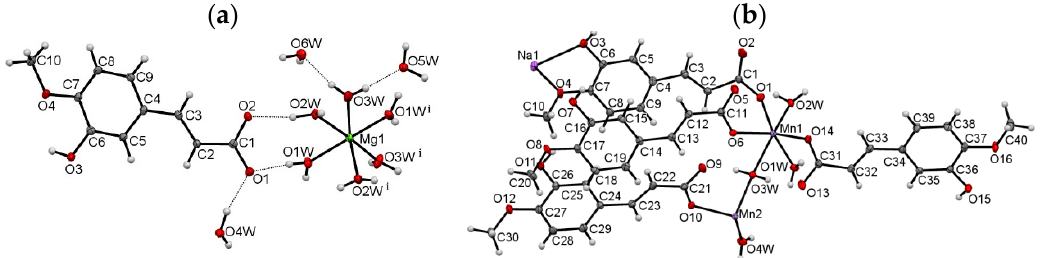
Figure 2. The asymmetric unit of: ( a ) [Mg(H 2 O) 6 ] · (C 10 H 9 O 4 ) 2 · 6H 2 O) and ( b ) [Mn 3 Na 2 (C 10 H 7 O 4 ) 8 (H 2 O) 8 ] n with the atom ‐ labeling scheme. Displacement ellipsoids are drawn at the 50% probability level. Dashed lines indicate hydrogen bonds. Symmetry code: (i) ‐ x, y, ‐ z +1/2.